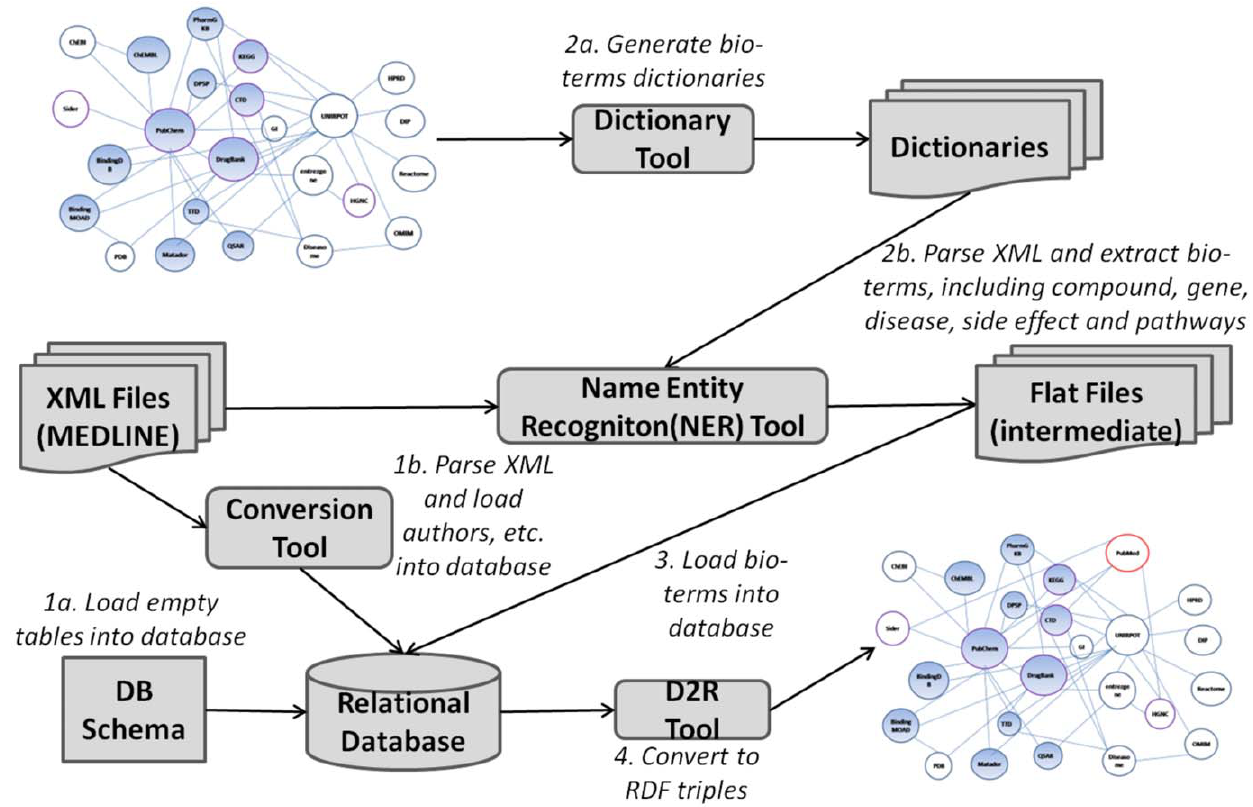
Figure 1. Data Preprocessing.